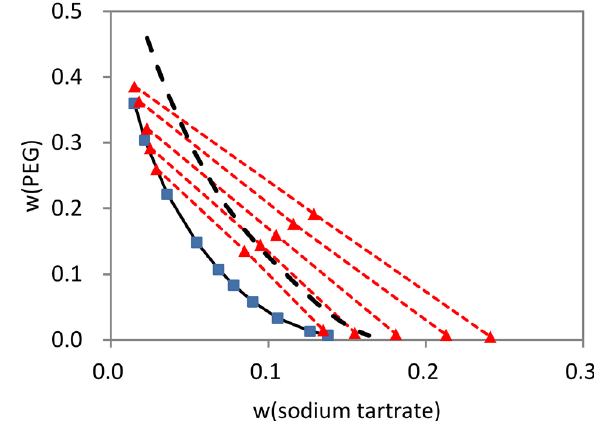
Figure 2: Binodal curve (■) and tie-line ( ▲ ) of PEG 10000 + sodium tartrate + H O at T = 298.15 K and P = 84 kPa. Dash line is the cloud 2 point data in [29] (PEG 4000 + sodium tartrate + H comparison.